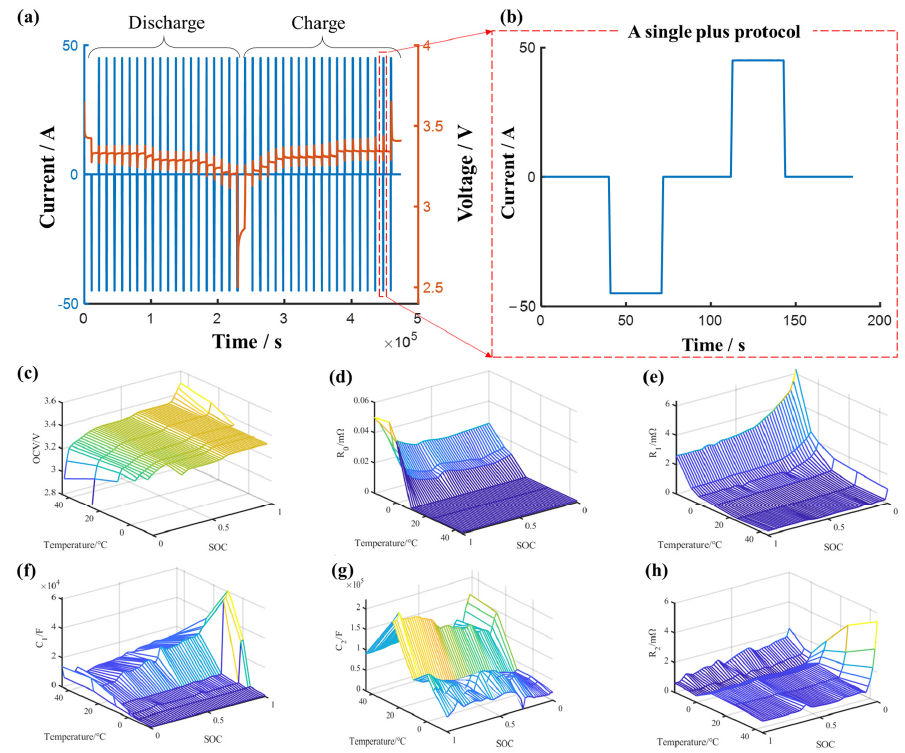
Figure 5. The HPPC test protocol and identified parameters of ECM. ( a ) Full protocol of the HPPC test. ( b ) A single plus protocol. ( c ) The identified OCV. ( d ) The identified R0. ( e ) The identified R1. ( f ) The identified C1. ( g ) The identified C2. ( h ) The identified R2.